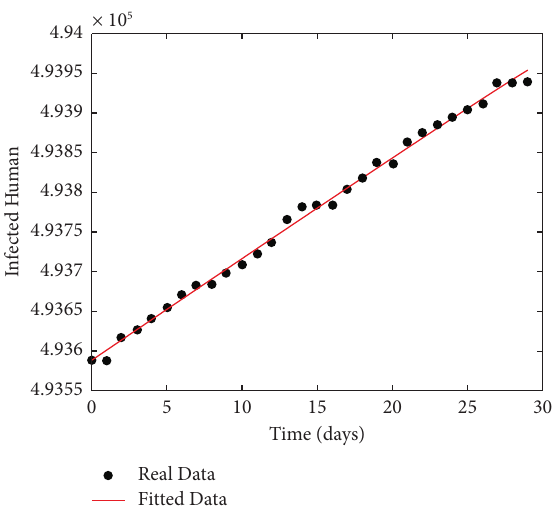
Figure 2: SEIHR model ft with real data on the number of COVID-19 cases in Ethiopia. Table 4: Parameters from literature value and estimated values used for model (1).